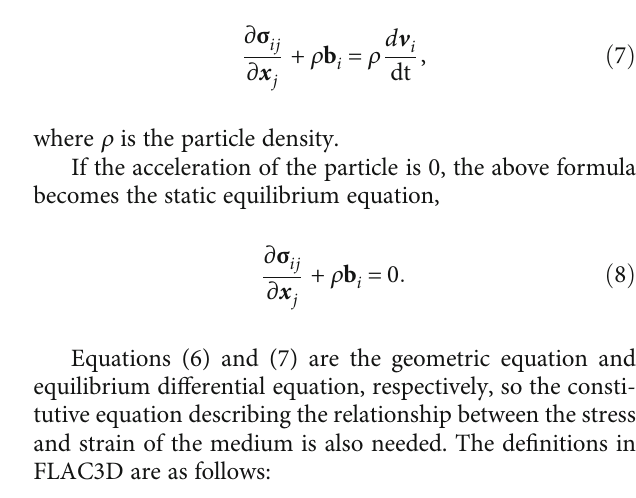
Figure 8: Vertical stress and height of the water level in the roof during the excavation process. (a) No. 1-No. 4, vertical stress. (b) No. 5-No. 8, vertical stress. (c) No. 9 and No. 10, vertical stress. (d) Height of water level and fracture